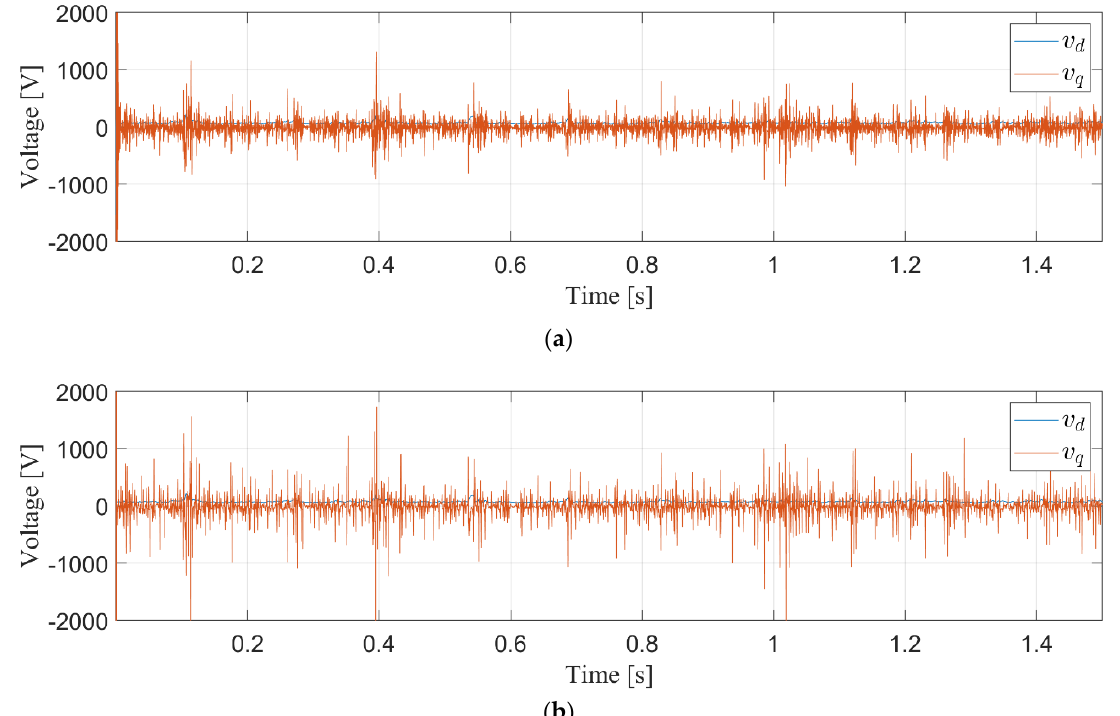
Figure 9. PMSG voltages for linear controller ( a ) and nonlinear controller ( b ).